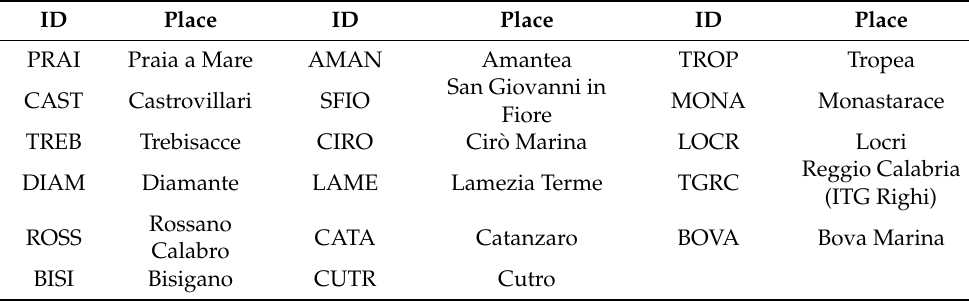
Table A3. Permanent GNSS stations of Calabria Region.